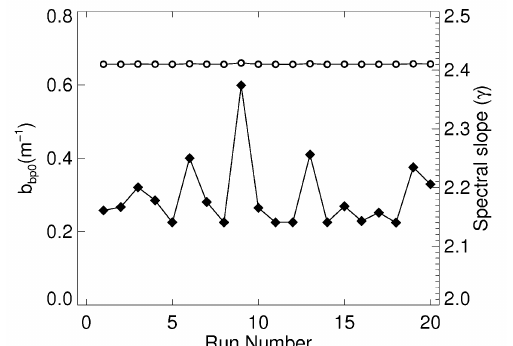
Figure 2 The magnitude of the retrieved bbp0 (closed diamonds) and spectral slope (  ) (open circles) values for the 20 runs.